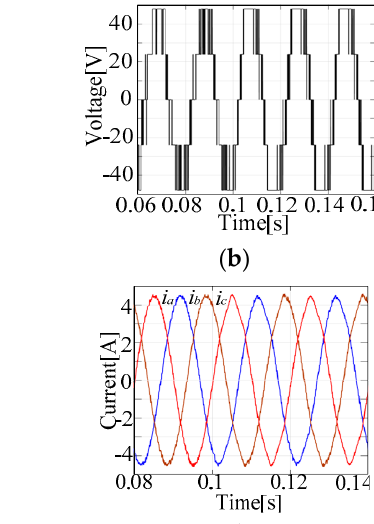
Figure 6. ( a ) Voltage for phase A. ( b ) Voltage for phase B. ( c ) Voltage for phase C. ( d ) Current for three phase.